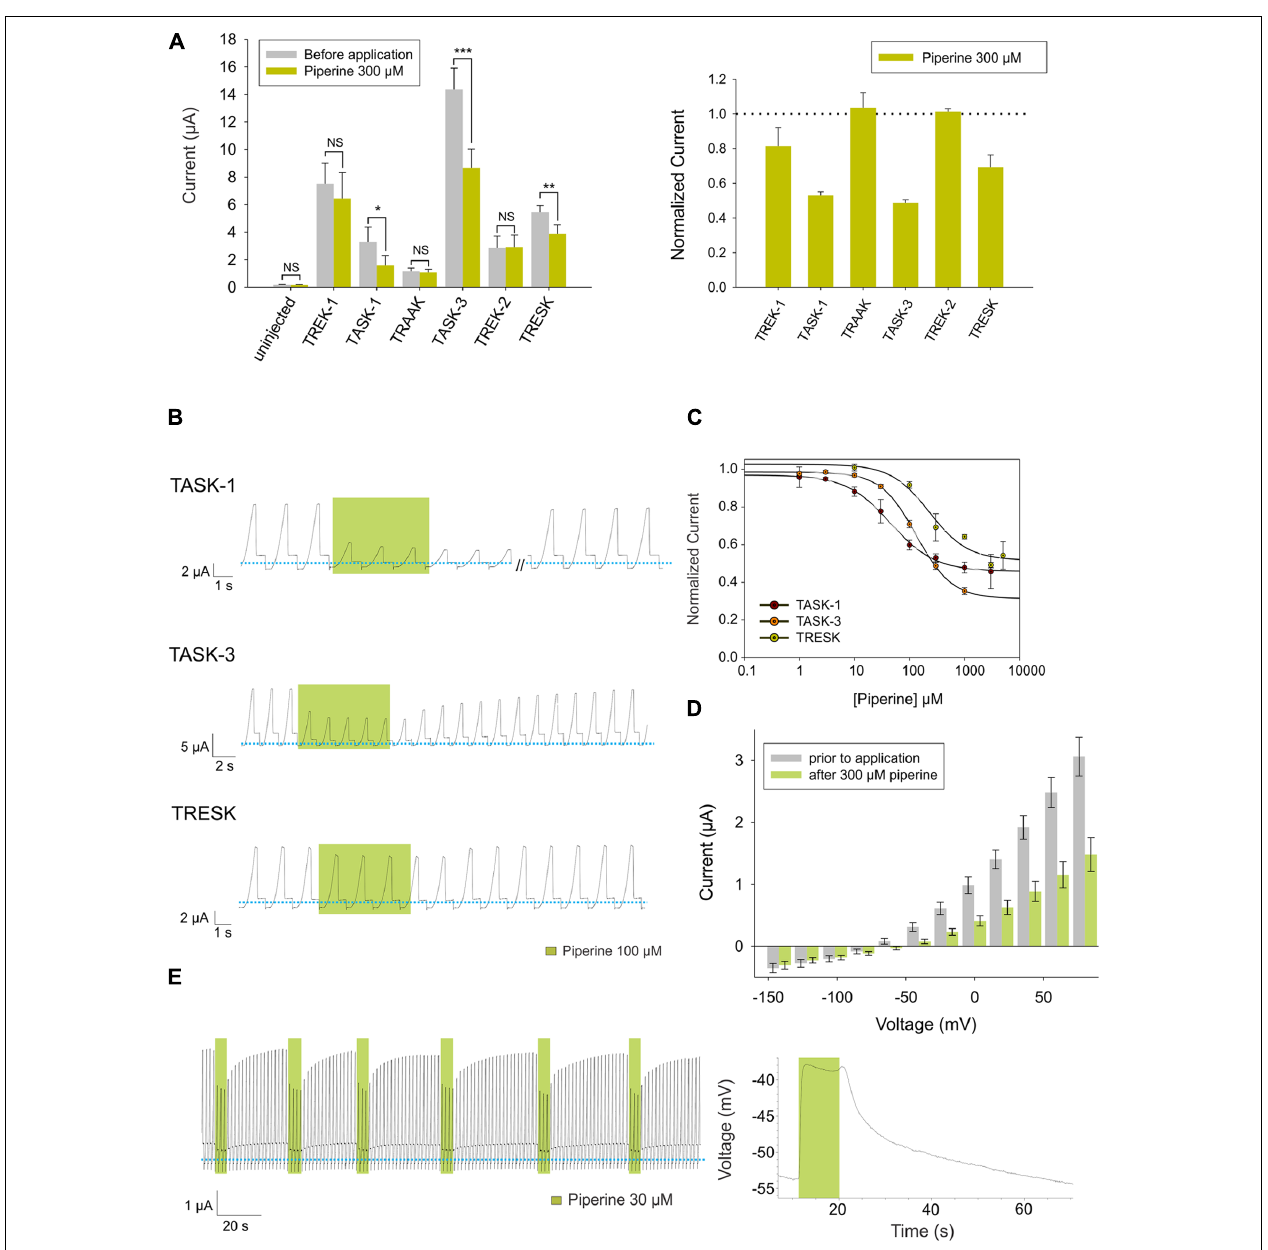
FIGURE 2 | (A) Left (from left to right) absolute currents presented by: uninjected Xenopus oocytes, oocytes injected with cRNA coding for hTREK-1, hTASK-1, hTRAAK, hTASK-3, hTREK-2 and hTRESK, before and after the application of 300 μ M piperine. The currents were registered at the final 50 ms of the + 50 mV constant (see methods for a description of the ramp protocol used). Note that the amount of current carried by uninjected oocytes is negligible in comparison to oocytes expressing a K 2P channel. Right . Normalized currents showing the effect of 300 μ M piperine on Xenopus oocytes injected with cRNA coding for hTREK-1, hTASK-1, hTREK-1, hTASK-3, hTREK-2 and hTRESK. For each group, the current was normalized to the current registered prior to the application of 300 μ M piperine (dotted line). All data are expressed as the mean + / − SEM. N of 3–6 for injected oocytes, N of 10 for uninjected oocytes. * P < 0.05, ** P < 0.01, *** P < 0.001. (B) Representative voltage clamp recordings of Xenopus laevis oocytes expressing hTASK-1 (top), hTASK-3 (middle) and hTRESK (bottom), before, during and after the application of 100 μ M